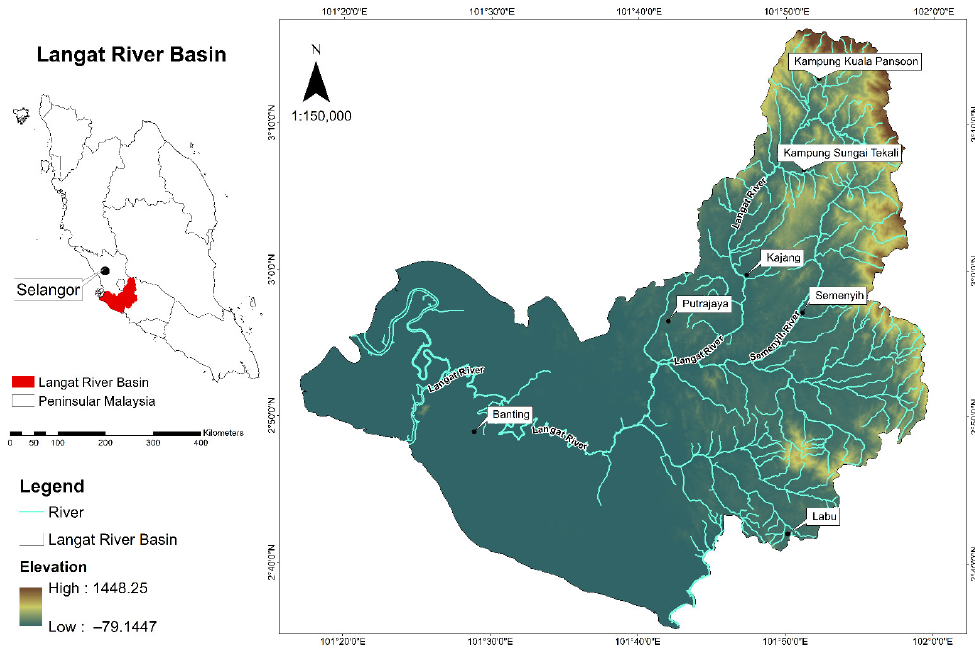
Figure 1. Study area at Langat Basin, Selangor.